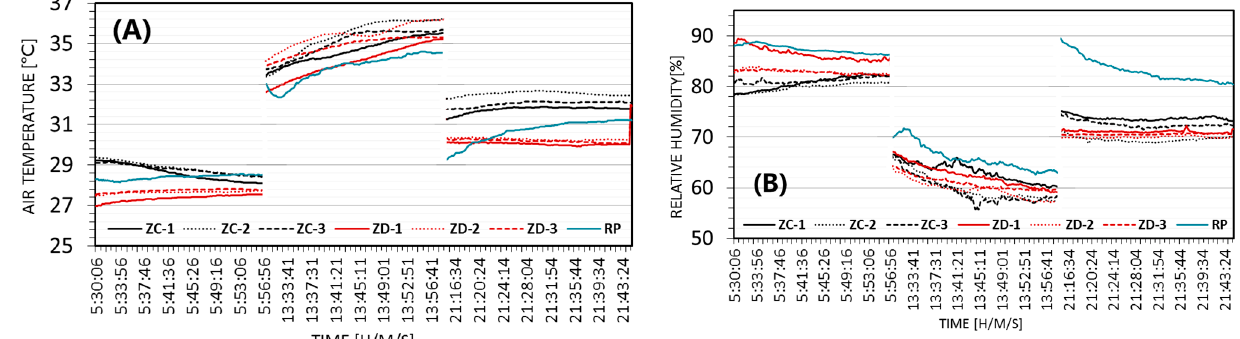
Figure 5. Four-day average ( A ) air temperatures and ( B ) relative humidity for six of the mobile measurement routes and for the reference point.